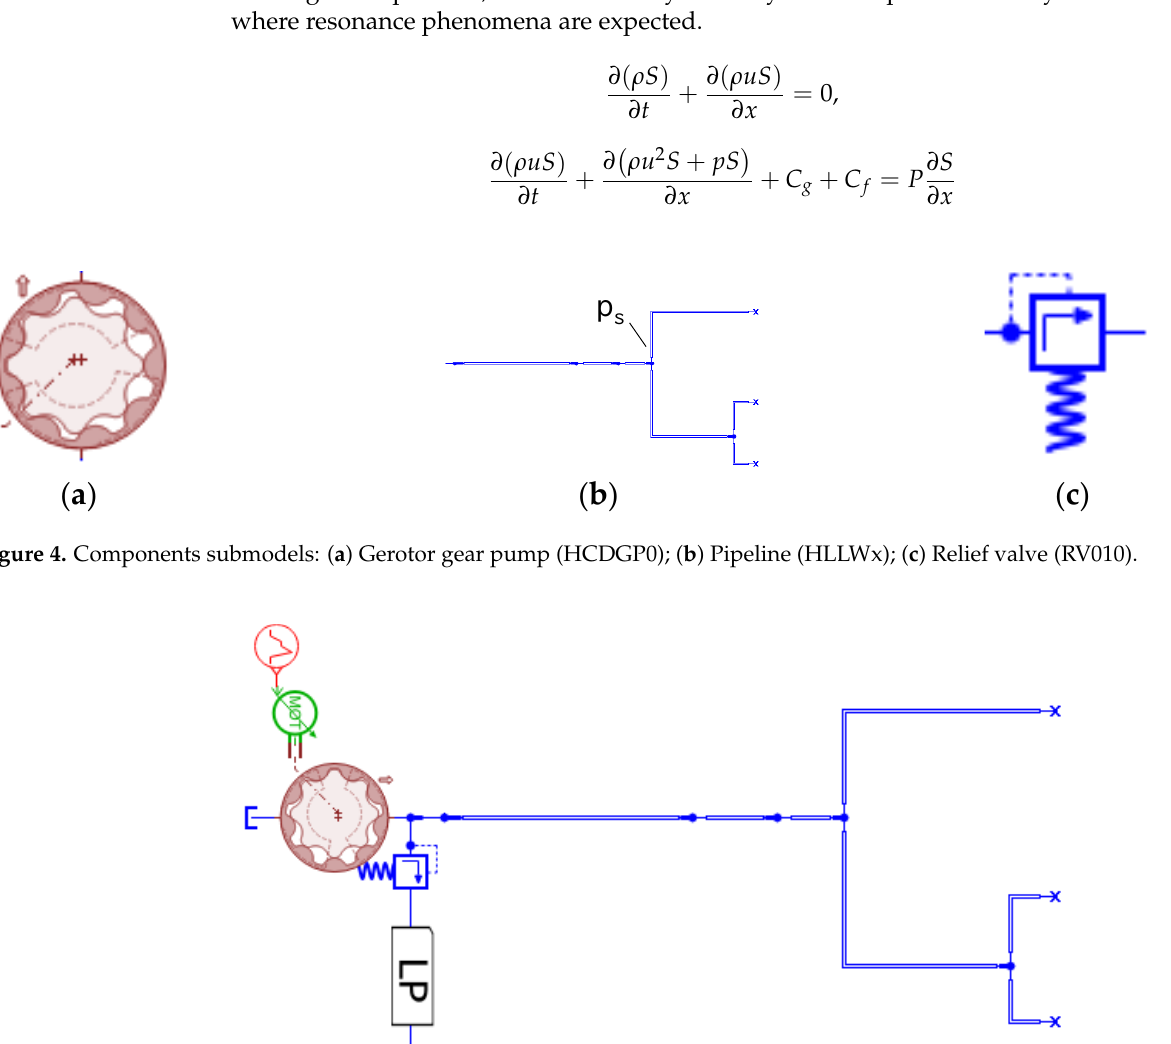
Figure 5. 0D/1D dynamic model of the base circuit.